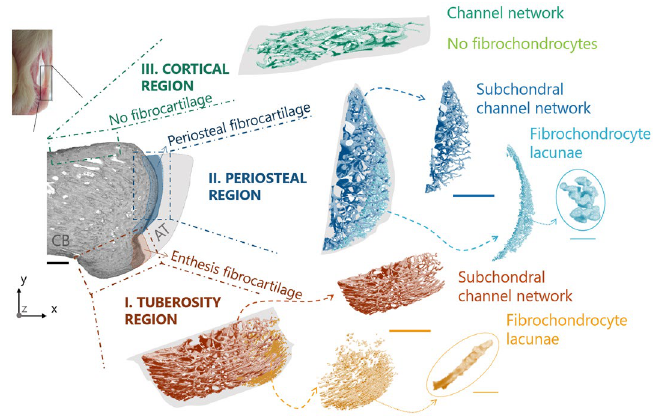
Figure 3. Representation of the three regions of interest defined for the analysis of bone microporosity along with three-dimensional renderings of the extracted subchondral channel network and fibrochondrocyte lacunae. The shaded gray area represents the considered tissue volume within each region. CB calcaneus bone, AT achilles tendon. Scale bars: 500 µm (bold), 50 µm